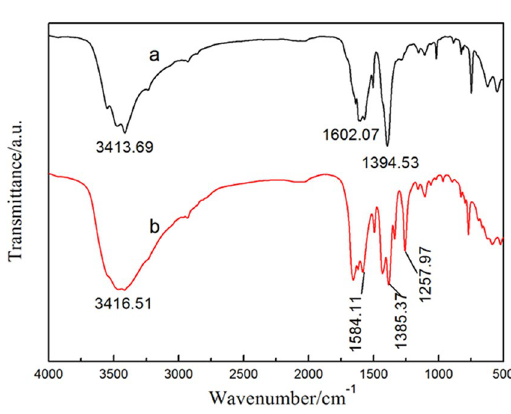
Figure 2. FT-IR spectra of Fe-based MOFs ( a ) MIL-101(Fe) and ( b ) NH 2